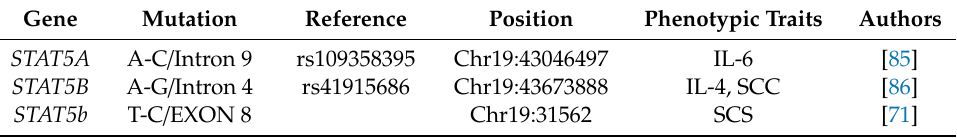
Table 2. Association of SNPs in STAT5A and STAT5B with bovine mastitis resistance phenotypic traits.